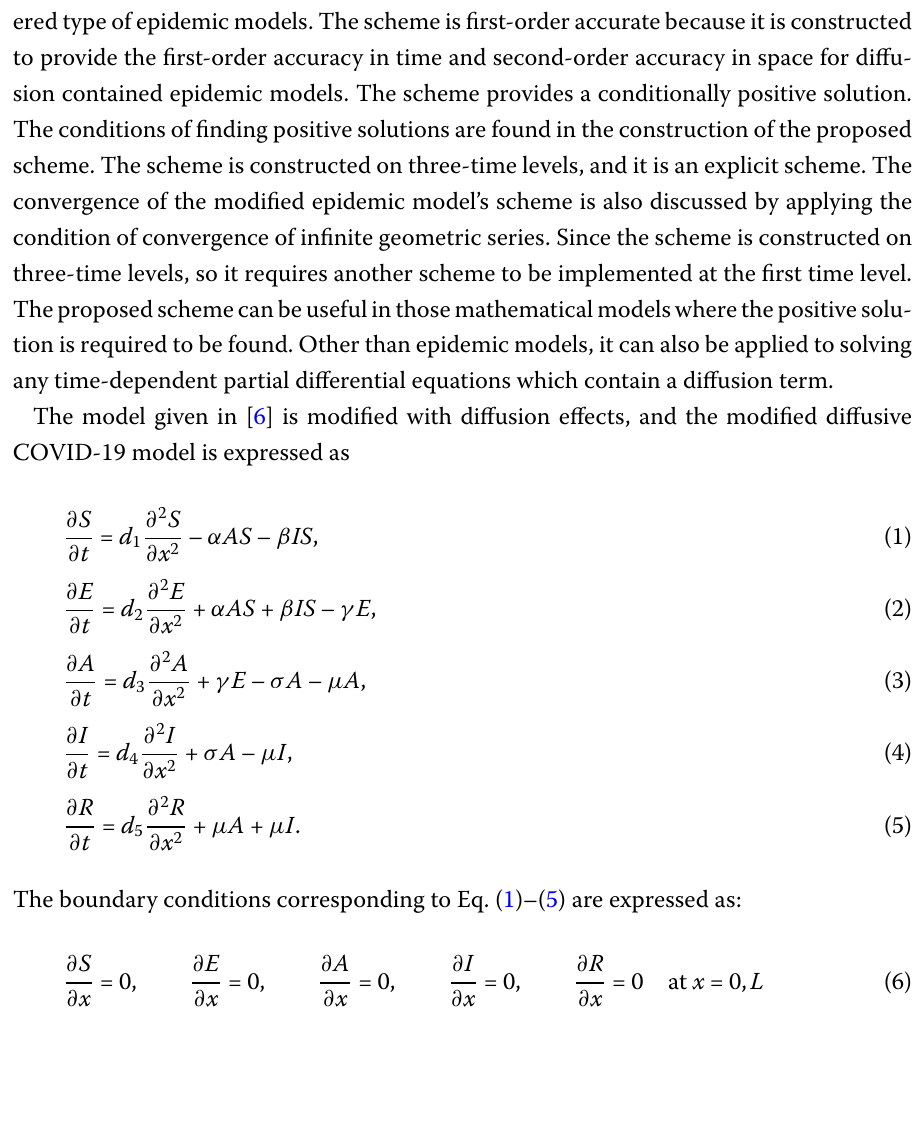
Fraction of Infective σ rate of those fraction of infectious hosts which have symptoms R Fraction of Recovered